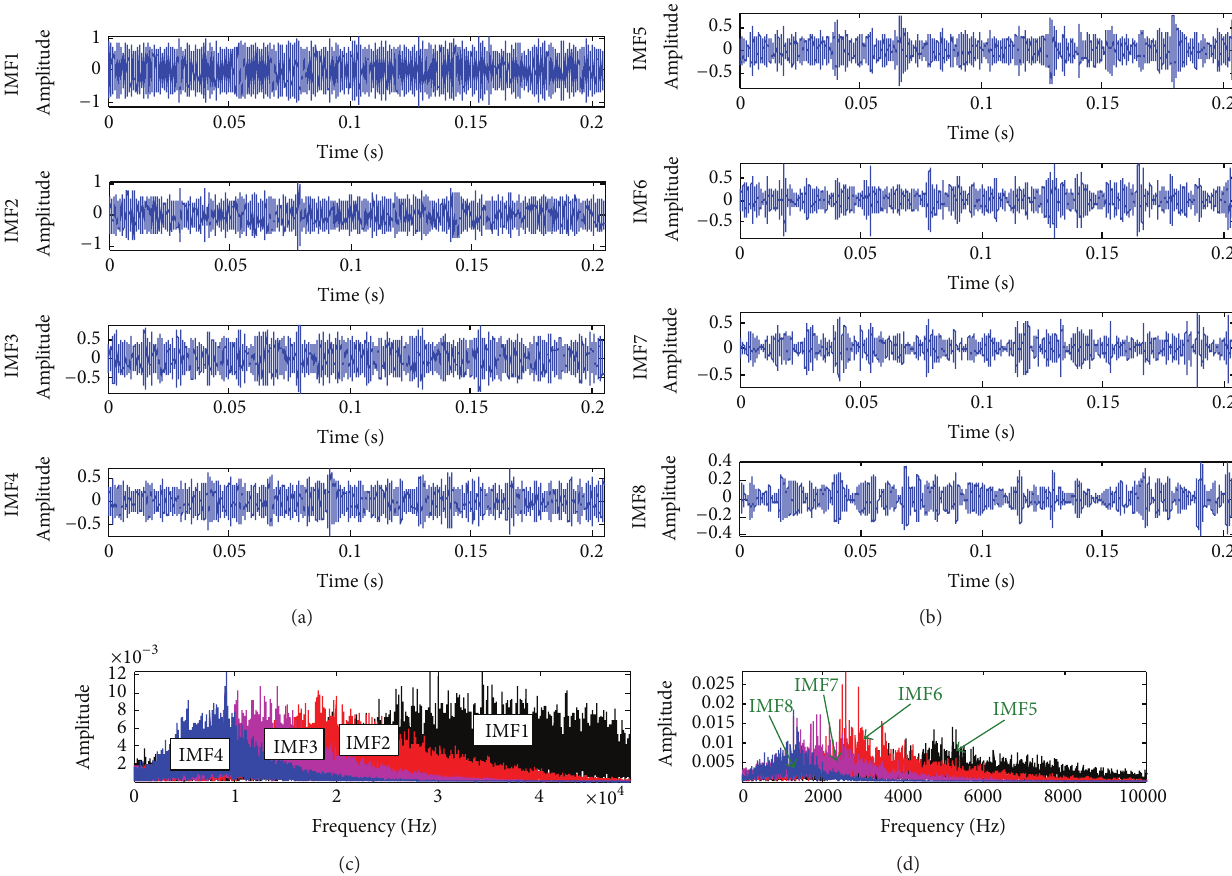
Figure 18: Decomposition results of the experimental signal shown in Figure 15(a) by EMD: (a) waveform of IMF1 ∼ IMF4, (b) waveform of IMF5 ∼ IMF8, (c) power spectrum of IMF1 ∼ IMF4, and (d) power spectrum of IMF5 ∼